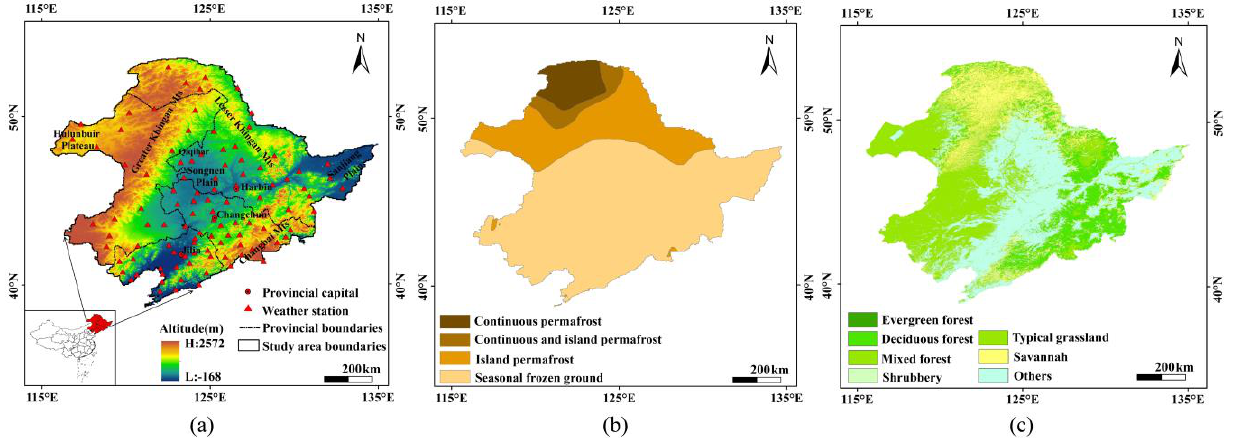
Figure 1. Location of the study area and the distribution of weather stations ( a ), permafrost distri- bution ( b ), and the type of vegetation cover ( c ), in the frozen ground region of northeast China.